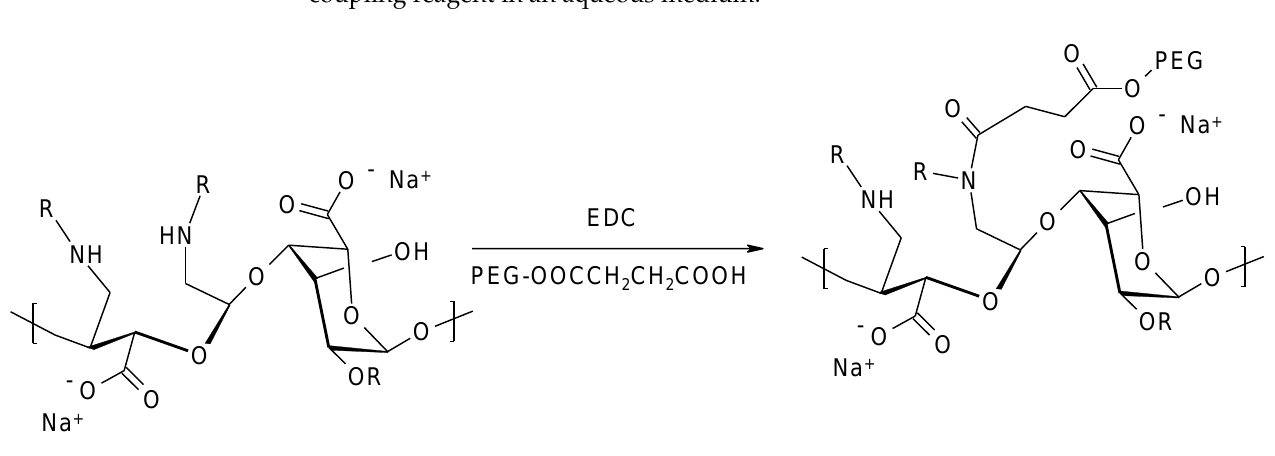
Figure 12. Reductive amination of oxidized sodium alginate.